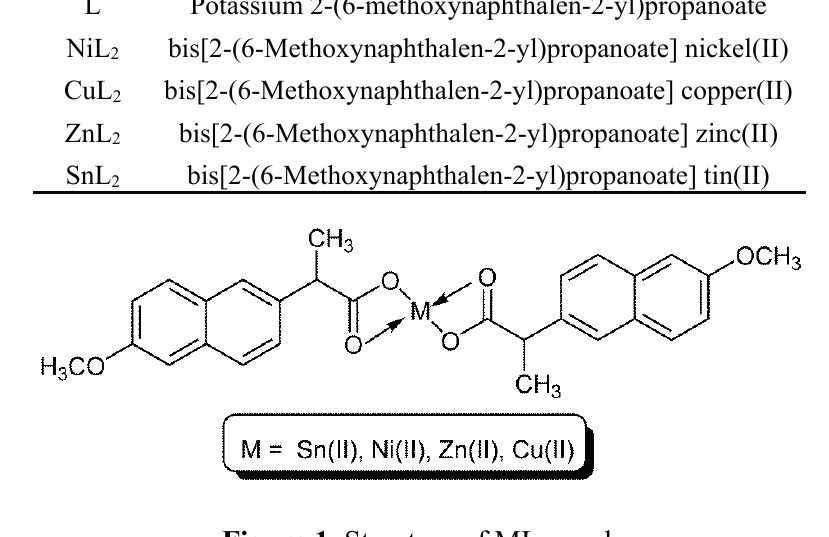
Figure 1. Structure of ML 2